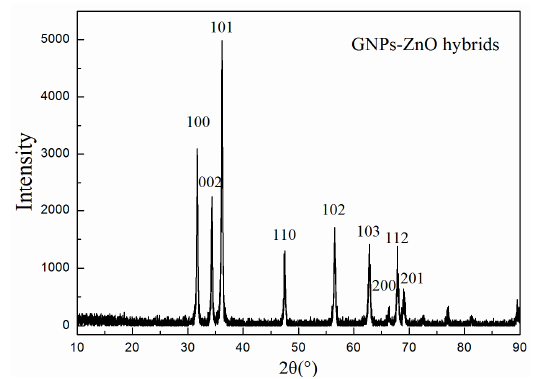
Figure 5. XRD spectrum of GO, RGO, and GNP-ZnO hybrids.